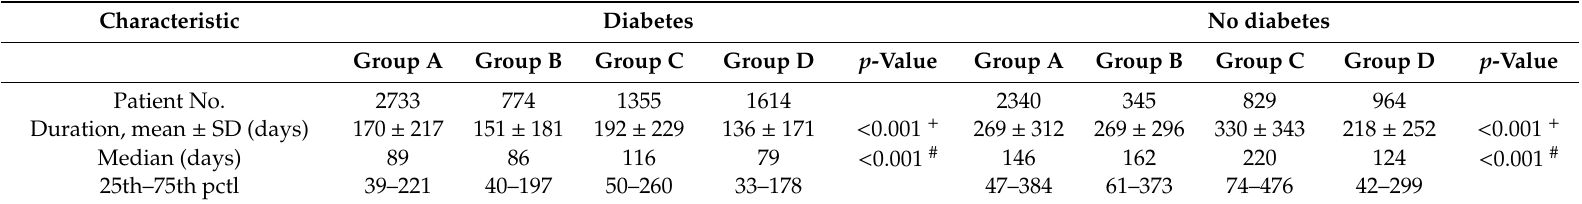
Table 3. Comparison of the predialysis duration among patients with and without diabetes by treatment group.